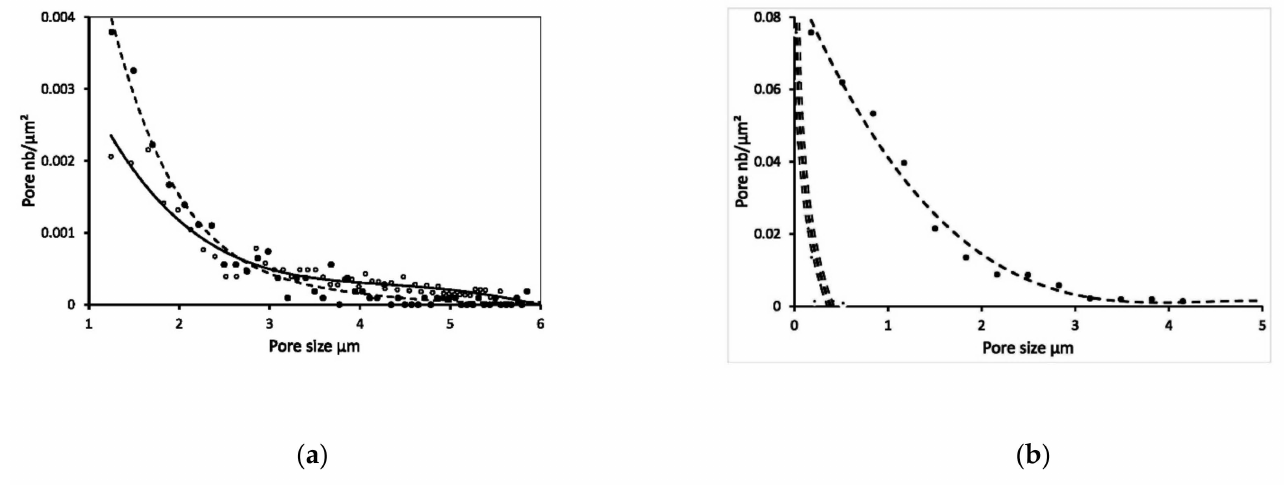
Figure 12. ( a ) Pore numbers per µ m 2 of HCR ( • ) and KORS (o) against the pore size; ( b ) Grain ( • ) and pore numbers (thick line) of KCR per µ m 2 against the grain and pore